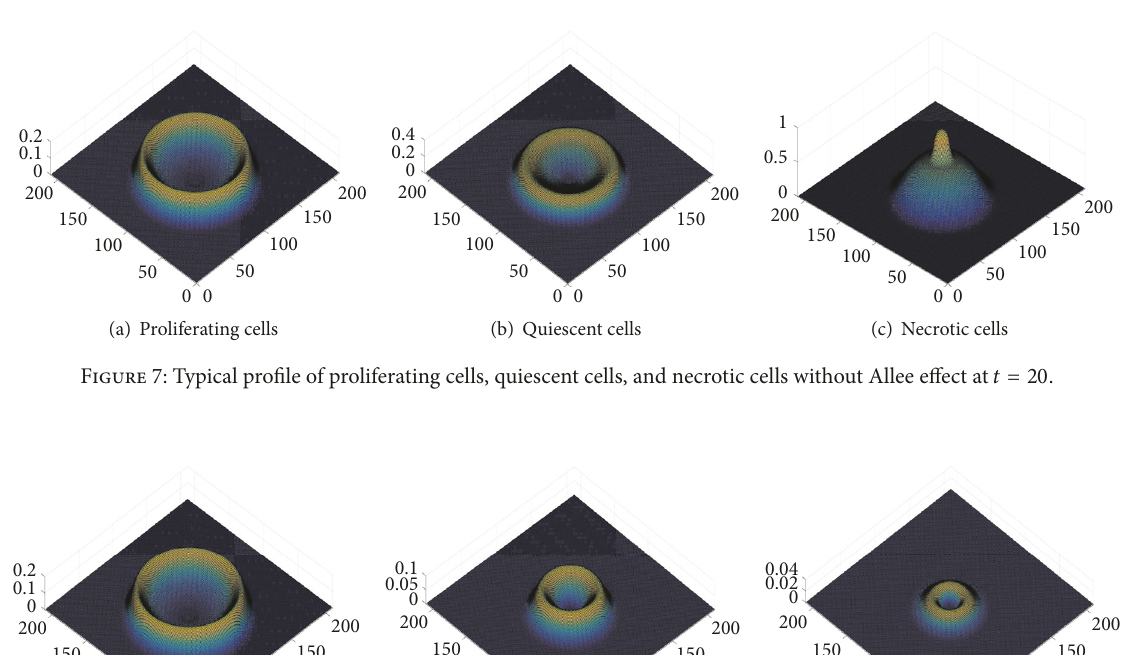
Figure 6: Impact of Allee effect: blue profile represents the density of the necrotic core; red profile represents the density of quiescent cells; the yellow profile represents the density of the proliferating rim.